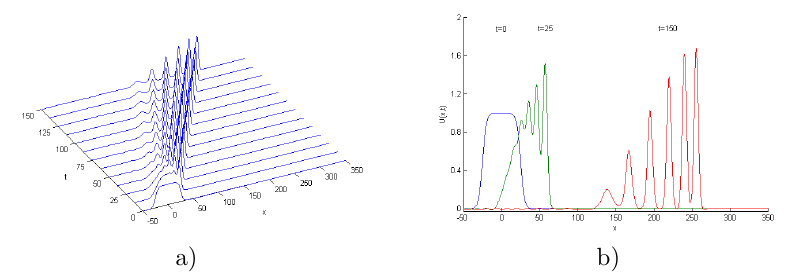
Figure 5. Developed train for a = b = c = 1, d = 0 . 5, v = 1 . 18 and h = ∆t = 0 . 1 of: a) solitons profile, b) solitons at specified